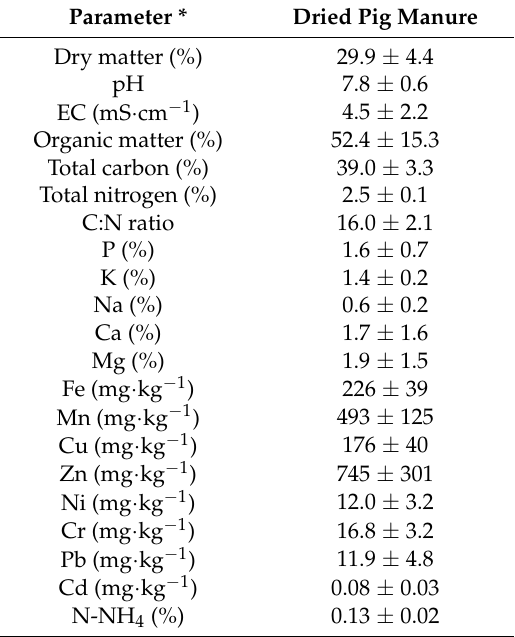
Table A2. Physicochemical properties of the dried pig